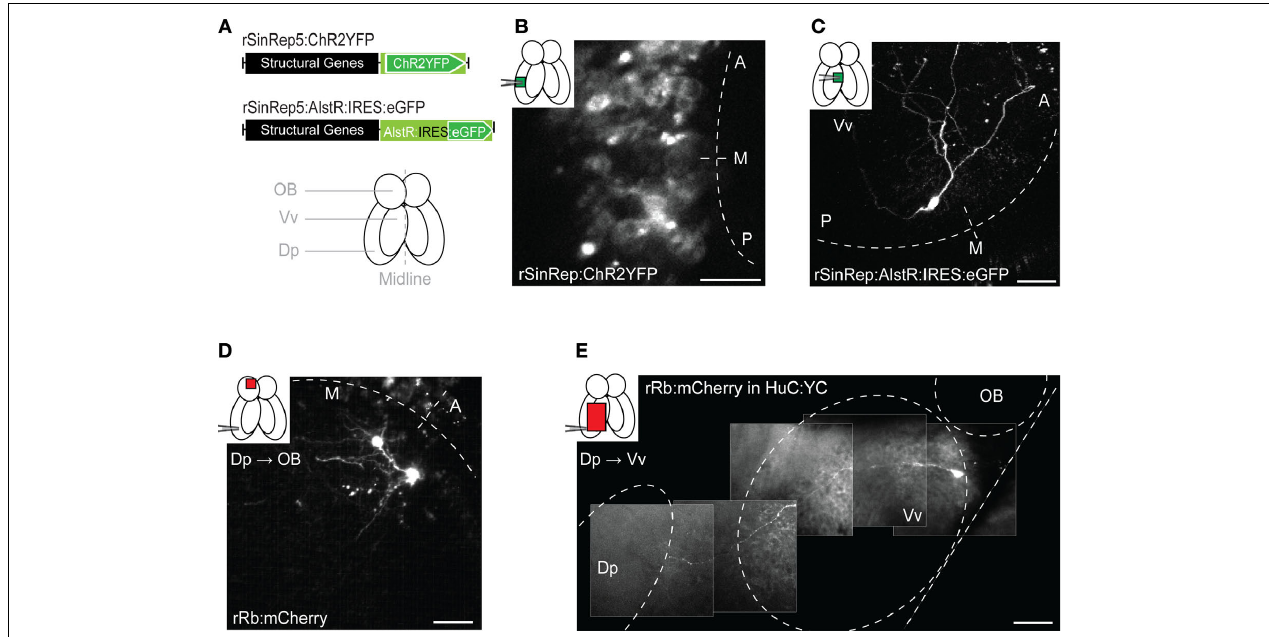
and visualized areas. Titer of injected virus was high in (B) and low in (C) . (D) All-or-none expression of mCherry in OB mitral cells after injection of Rabies virus in a target area (Dp), indicating retrograde tracing. (E) Visualization of an axonal trajectory from Vv to Dp in a HuC:YC transgenic fi sh. Background fl uorescence is from YC. Scale bars: 50